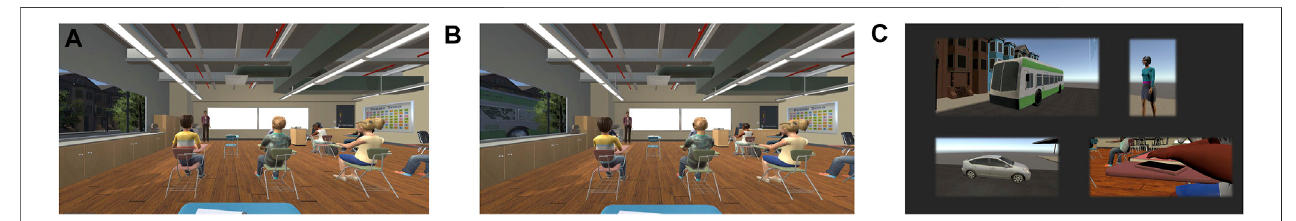
FIGURE 1 | Virtual classroom and example distractors. (A) View of the classroom from the participant ’ s perspective with distractors off. (B) View of the classroom from the participant ’ s perspective looking out the window with the bus distractor on. (C) Sample of distractors - bus, car, and pedestrian walking by the window, and a phone ringing on another student ’ s